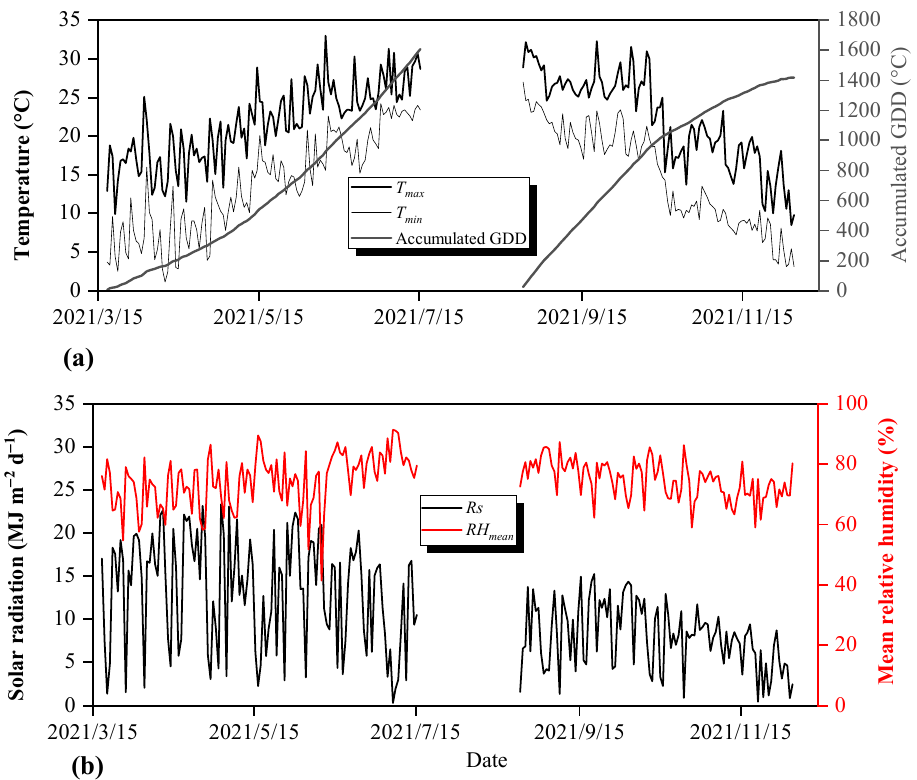
Figure 6. Meteorological condition from sowing to harvest of potato in two growing seasons in 2021.